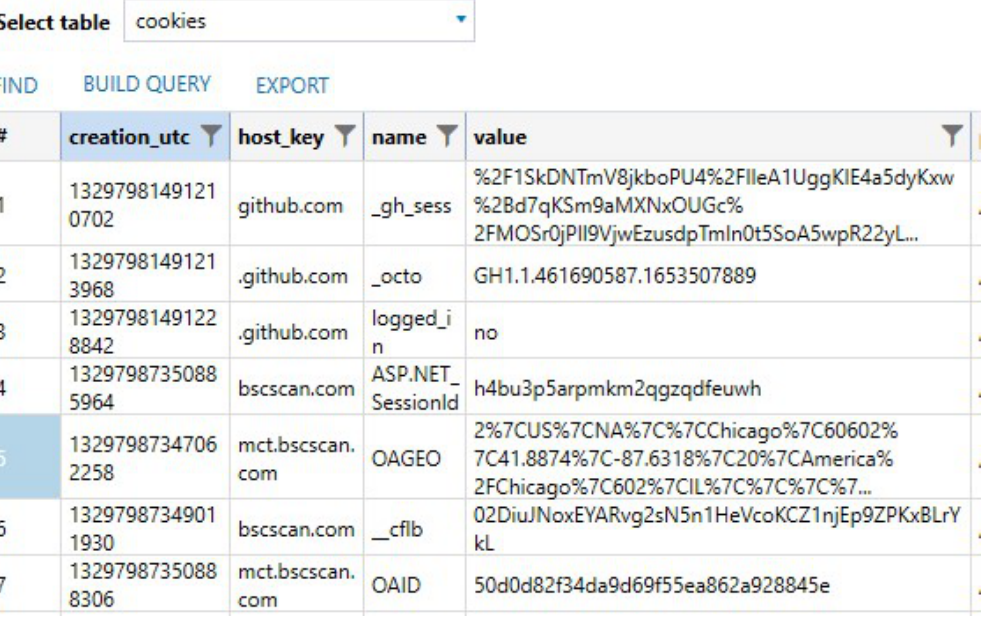
Figure 29. Cookie values show geolocation.